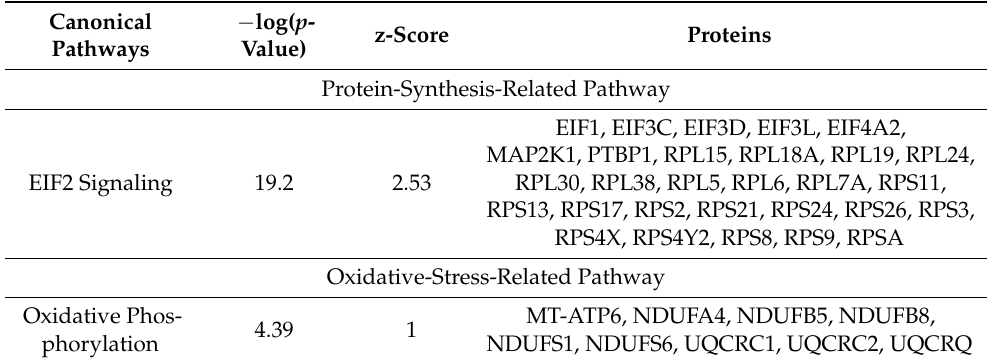
Table 1. IPA Canonical pathways for the 10 µ g/mL of nicotine vs. PBS.